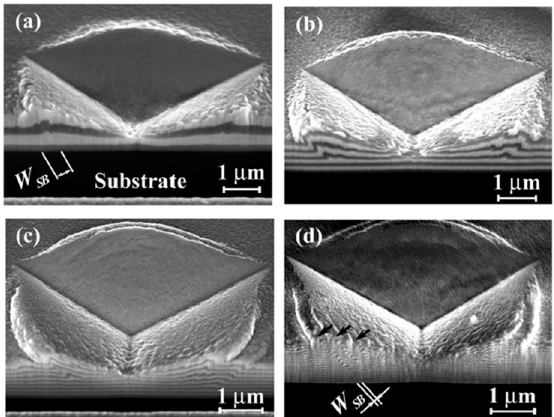
Figure 24. FIB cross-sectional views of the indents in the Au/Cu multilayers with h of ( a ) 250 nm, ( b ) 100 nm, ( c ) 50 nm, and ( d ) 25 nm [143].